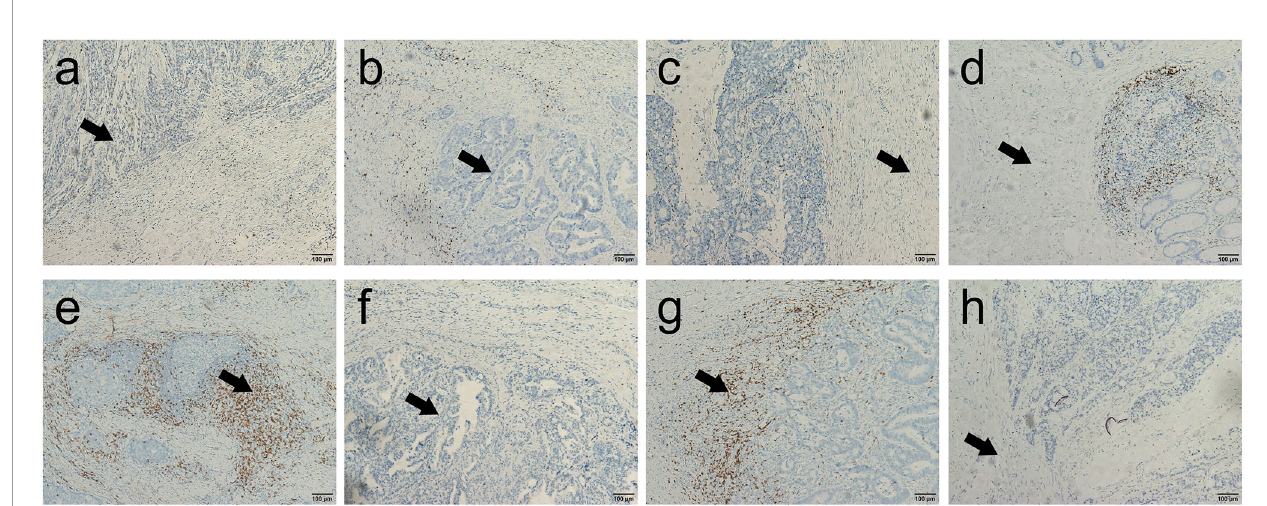
FIGURE 1 | Representative immunohistochemical images of CD3+ and CD8+ T cells in the core of the tumor (CT) and in the invasive margin (IM) of colorectal cancer (200×). (A, B) Representative images of high-density and low-density CD3+ T cells in the center of the colorectal cancer; (C, D) Representative images of high-density and low-density CD3+ T cells in the invasive margin of the colorectal cancer; (E, F) Representative images of high-density and low-density CD8+ T cells in the center of the colorectal cancer; (G, H) Representative images of high-density and low-density CD8+ T cells in the invasive margin of the colorectal